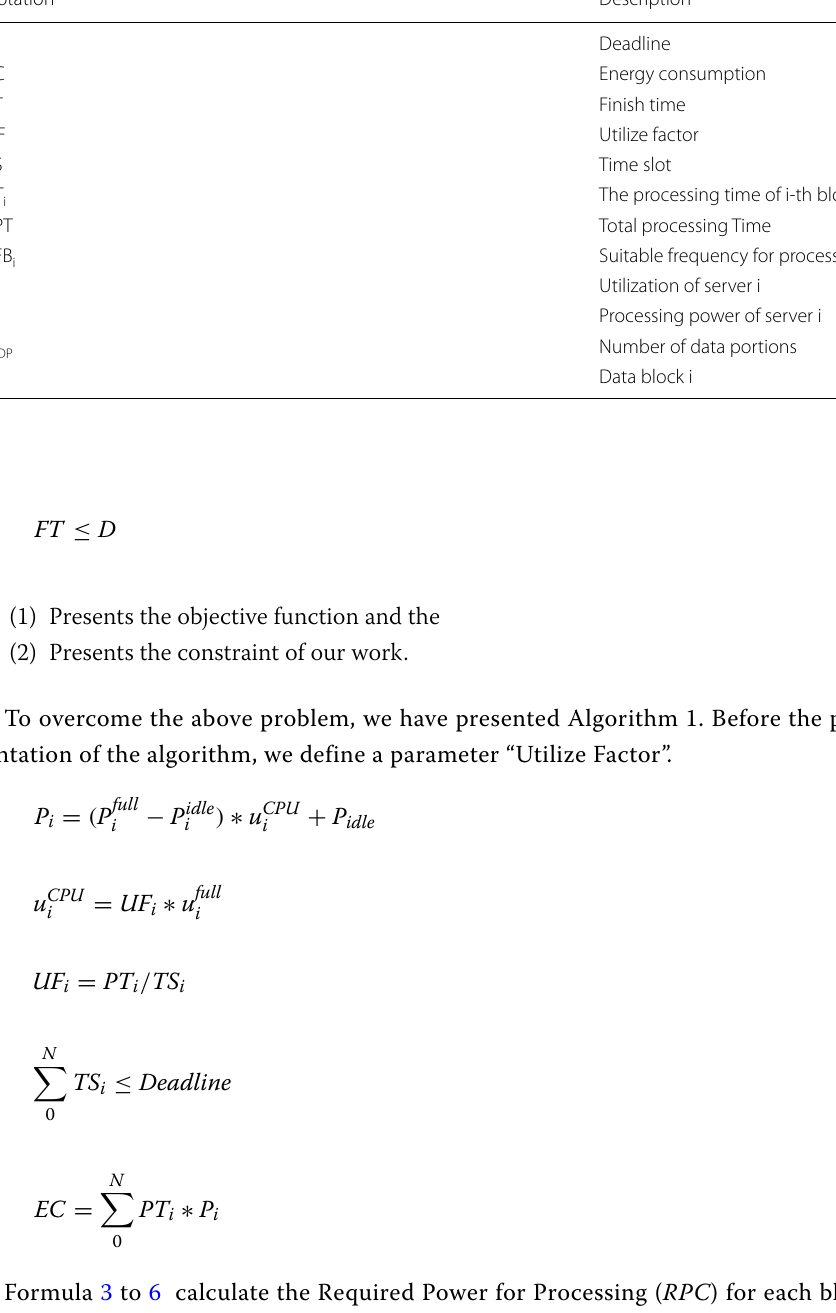
Table 2 Notations used in this paper